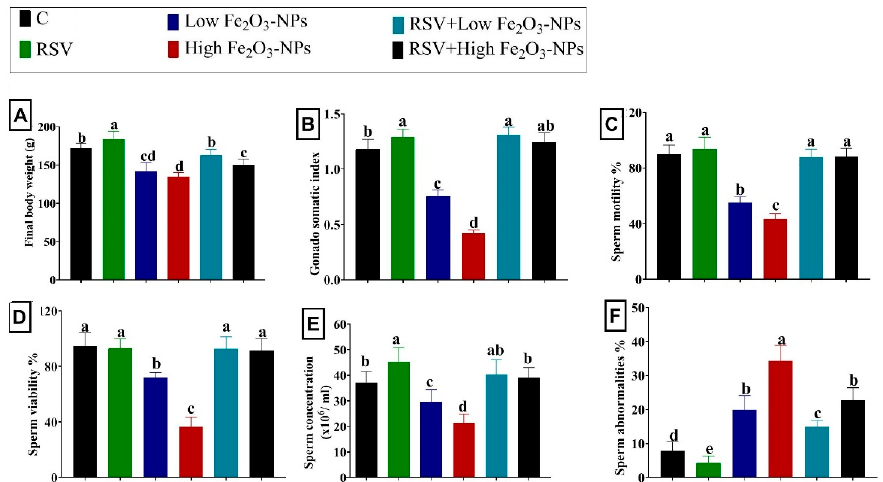
Figure 2. Effect of resveratrol (RSV; 20 mg/kg b.wt) and/or iron oxide nanoparticles (Fe 2 O 3 -NPs